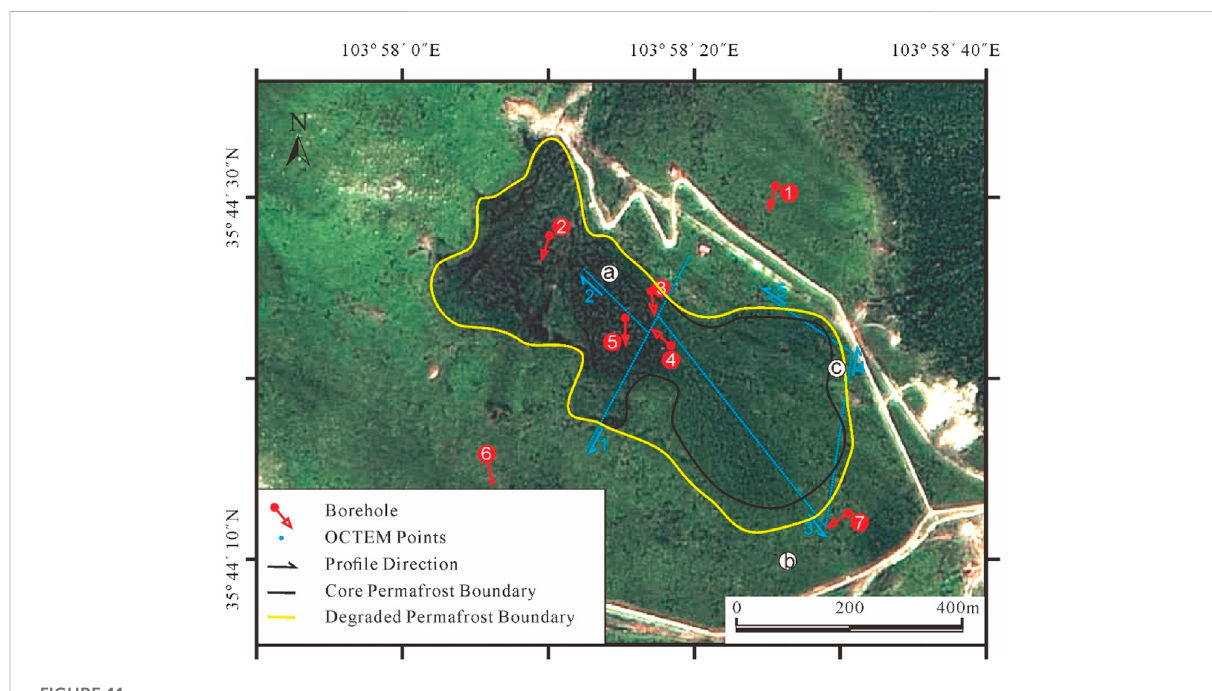
FIGURE 11 Distribution range of permafrost in Mahan Mountain based on geophysical exploration and surface vegetation